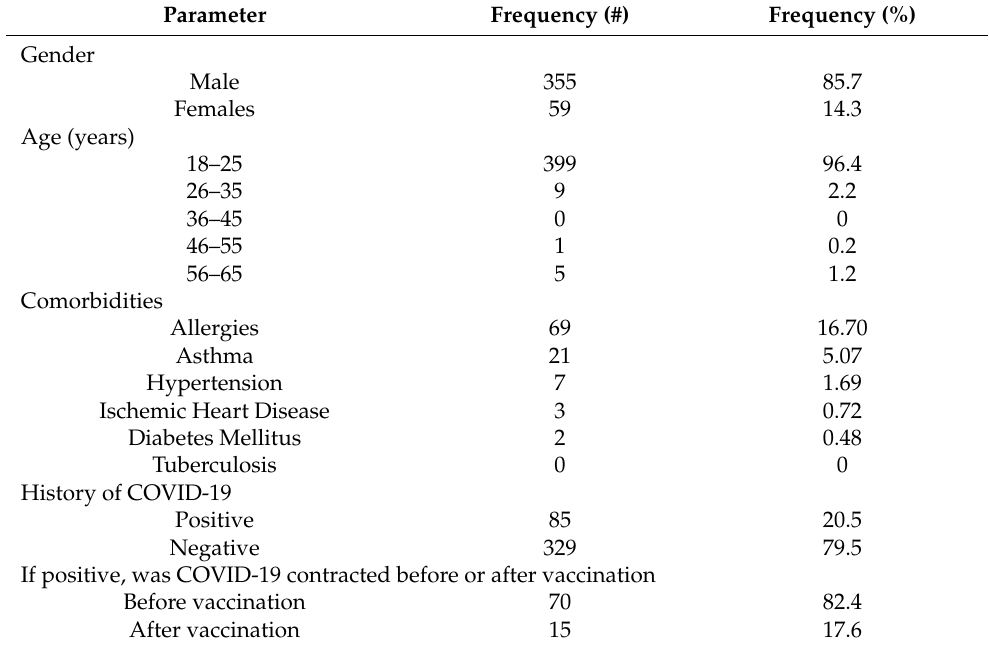
Table 1. Sociodemographic data along with the statistics of the COVID-19 history of